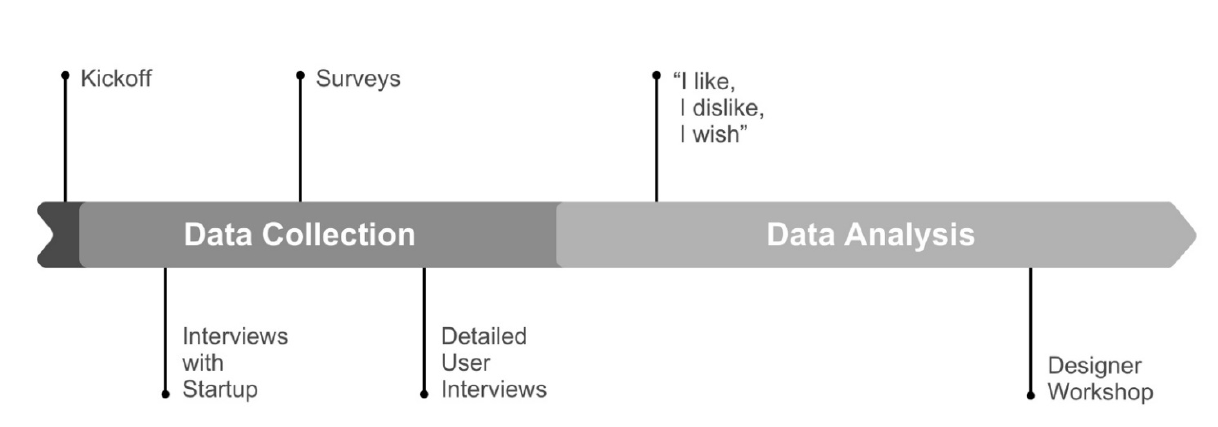
Figure 4: Methods using the process of Enterprise B